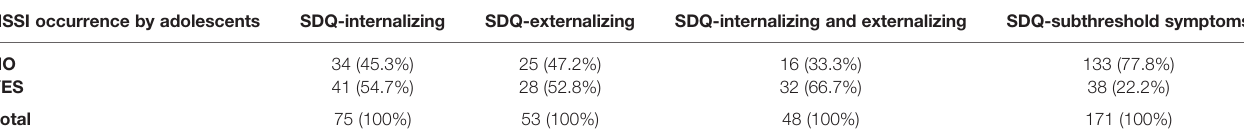
TABLE 2 | Occurrence of NSSI by SDQ groups (how many people have NSSI by SDQ